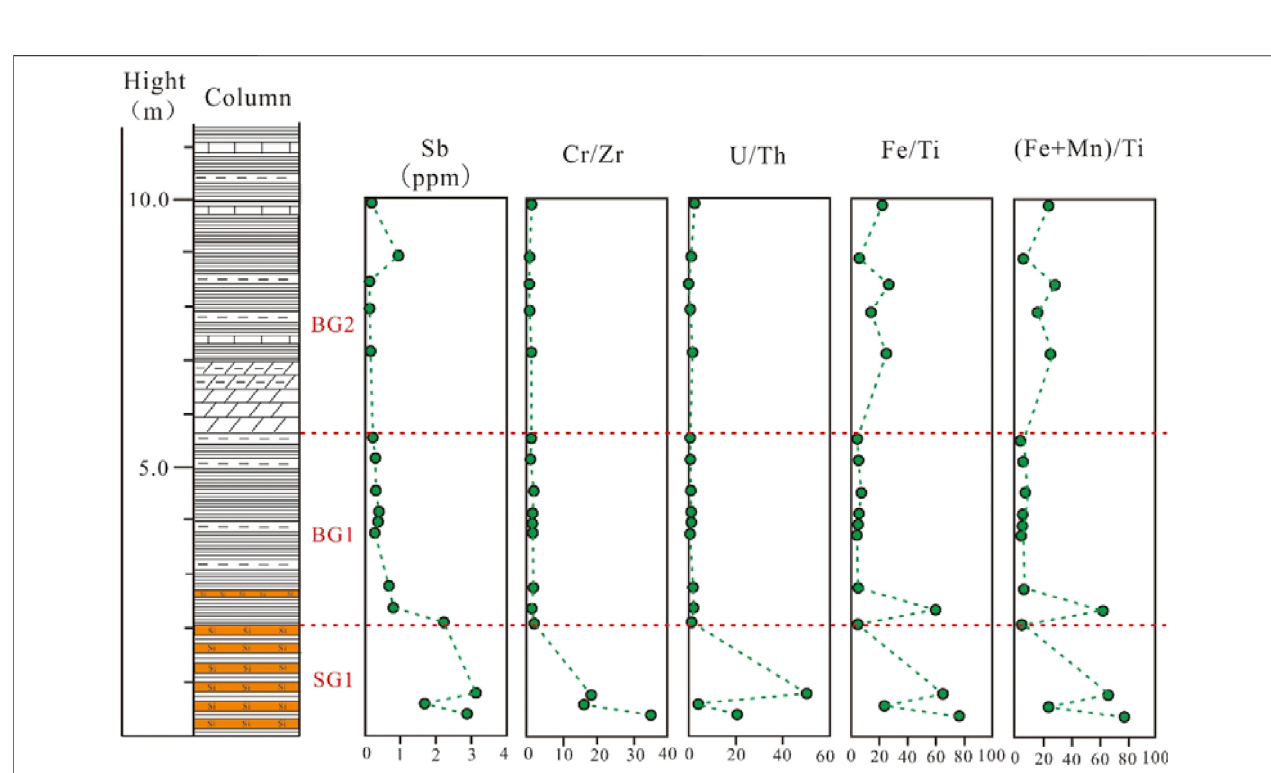
FIGURE 7 | Variation of Sb, Cr/Zr, U/Th, Fe/Ti, and (Fe + Mn)/Ti with depth.